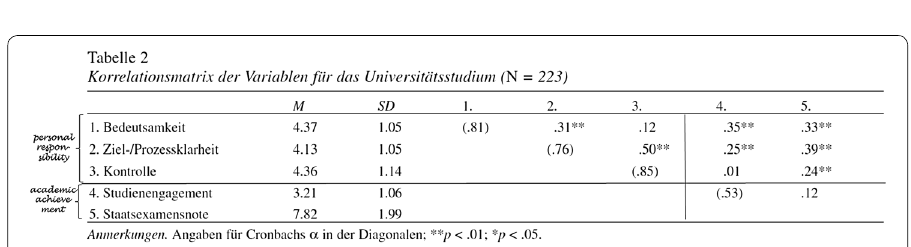
Fig. 2 Correlation matrix presented in the study by Koch